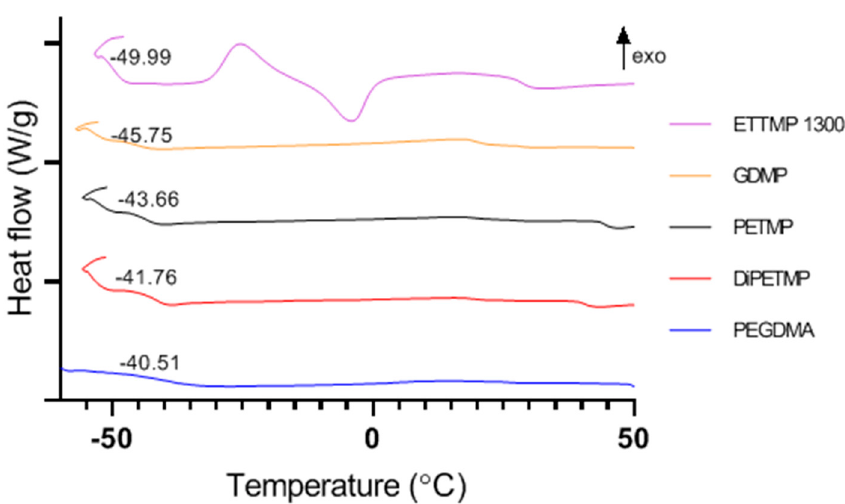
Figure 6. Differential scanning calorimetry highlighting the glass transition temperatures for PEGDMA and the different PEGDMA-thiol hydrogels.